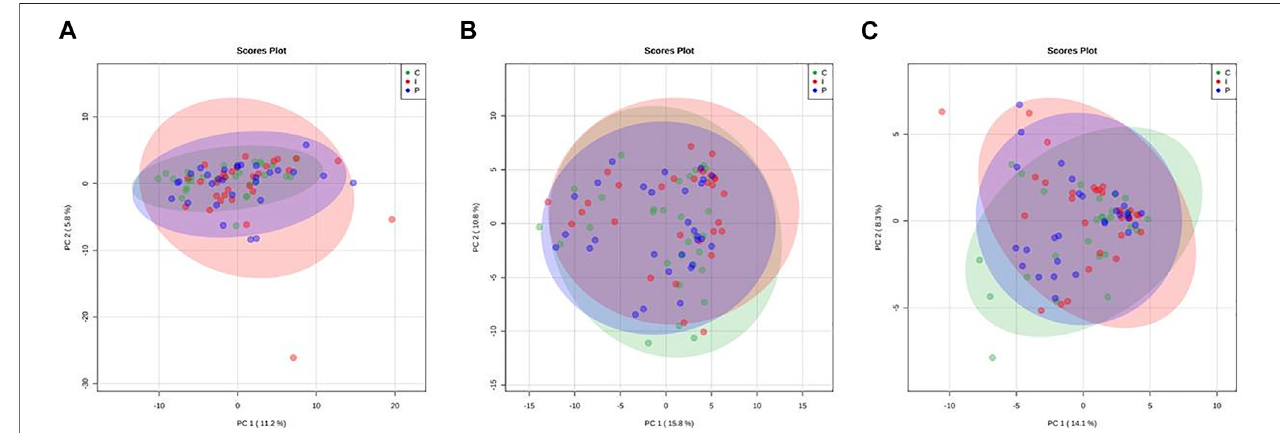
FIGURE3| Principalcomponentanalysis(PCA) scoresplotsrelated to1D 1 HNMRspectraofliveraqueous (A) andlipidextracts (B) and frommusclelipidfraction (C) fromrainbowtroutfeddifferentexperimentaldiets(C:controldiet,green;I:insectmealdiet,red;P:poultryby-productsmealdiet,blue).Coloredellipsesdescribethe T 2 -Hotelling 95% con fi dence intervals of each dietary group.